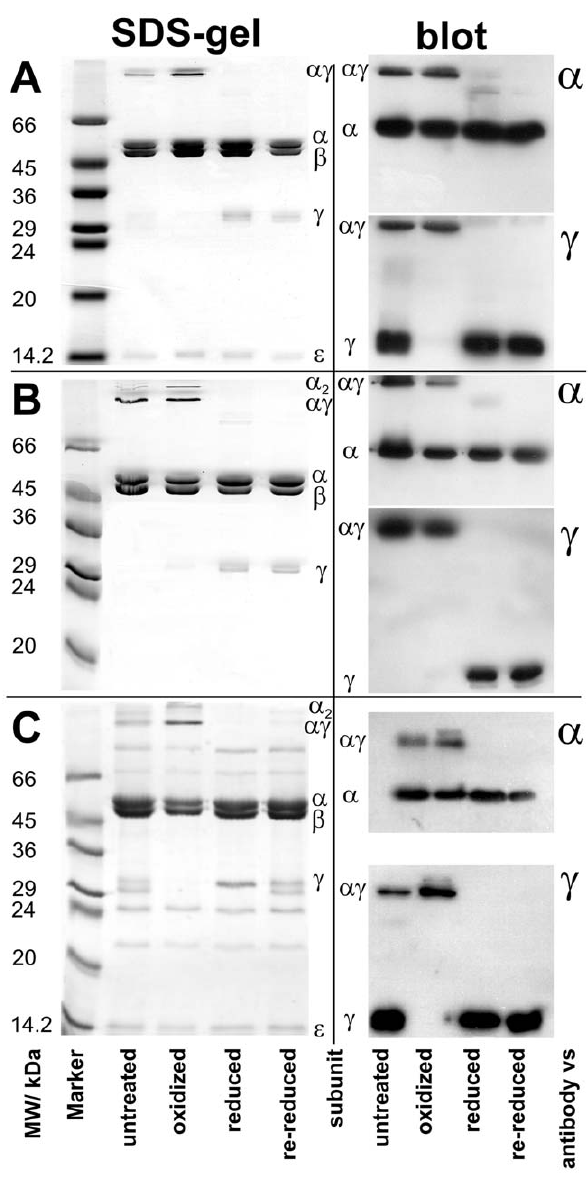
Figure 2. SDS-gels and immunoblots of EF 1 mutants. Gels and Blots for GH54, FH4, and GH19 are shown in A, B, and C, respectively. For each mutant the SDS-gel is shown on the left, while the respective blots are shown on the right, on top against subunit a , and at the bottom against subunit c . Samples are shown untreated, after oxidation with 400 m M DTNB, after reduction with 10 mM DTT, and re-reduced (after previous oxidation) with 30 mM DTT. The samples were incubated overnight with the respective